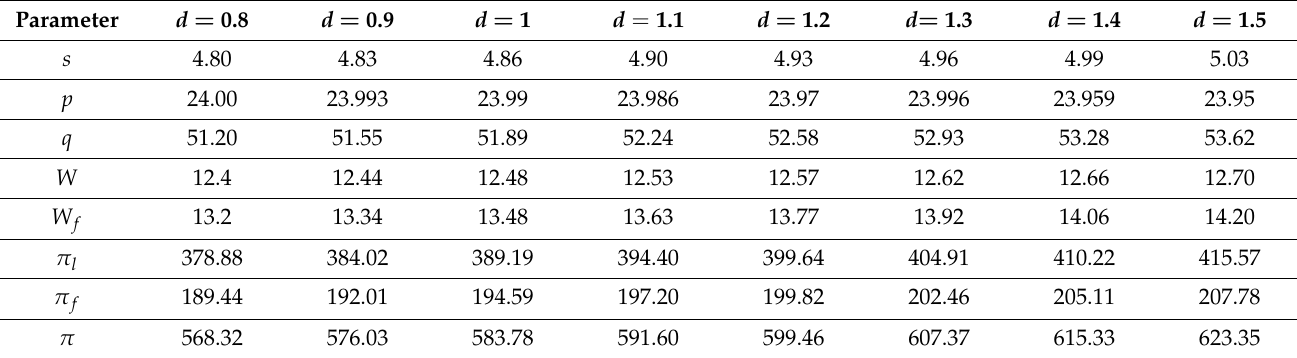
Table 10. Sensitivity analysis of changes in government subsidy proportion.